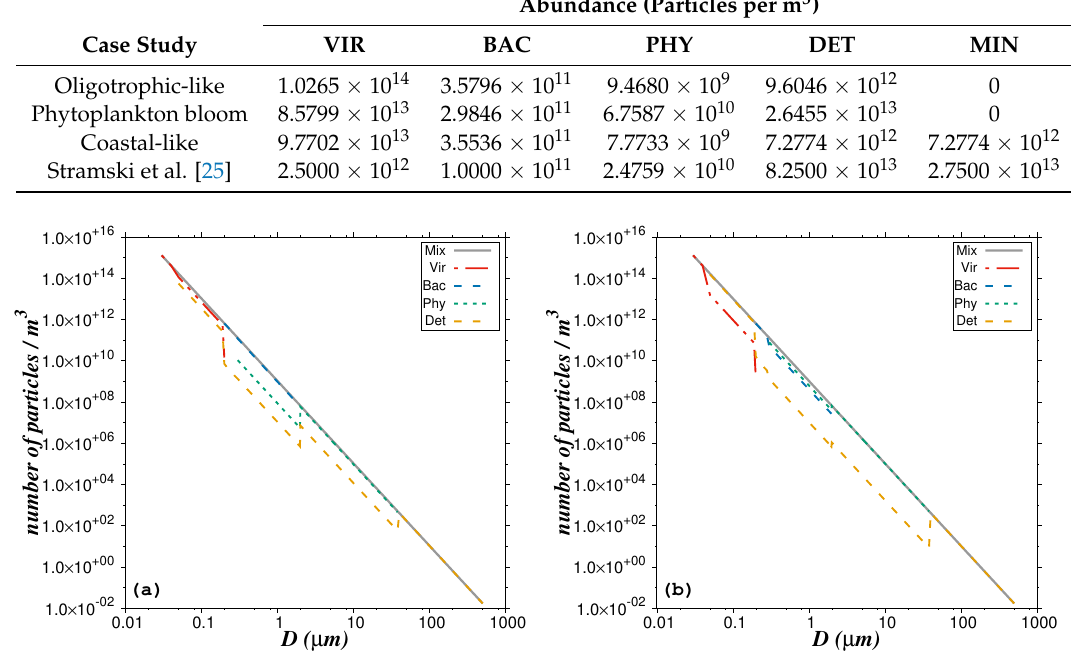
Figure 2. Composite PSD as derived from individual PSDs of the five considered particle groups for ( a ) the oligotrophic-like water body and ( b ) the phytoplankton bloom water body. N TOT = 1.1262 × 10 14 particles per m 3 and ξ =